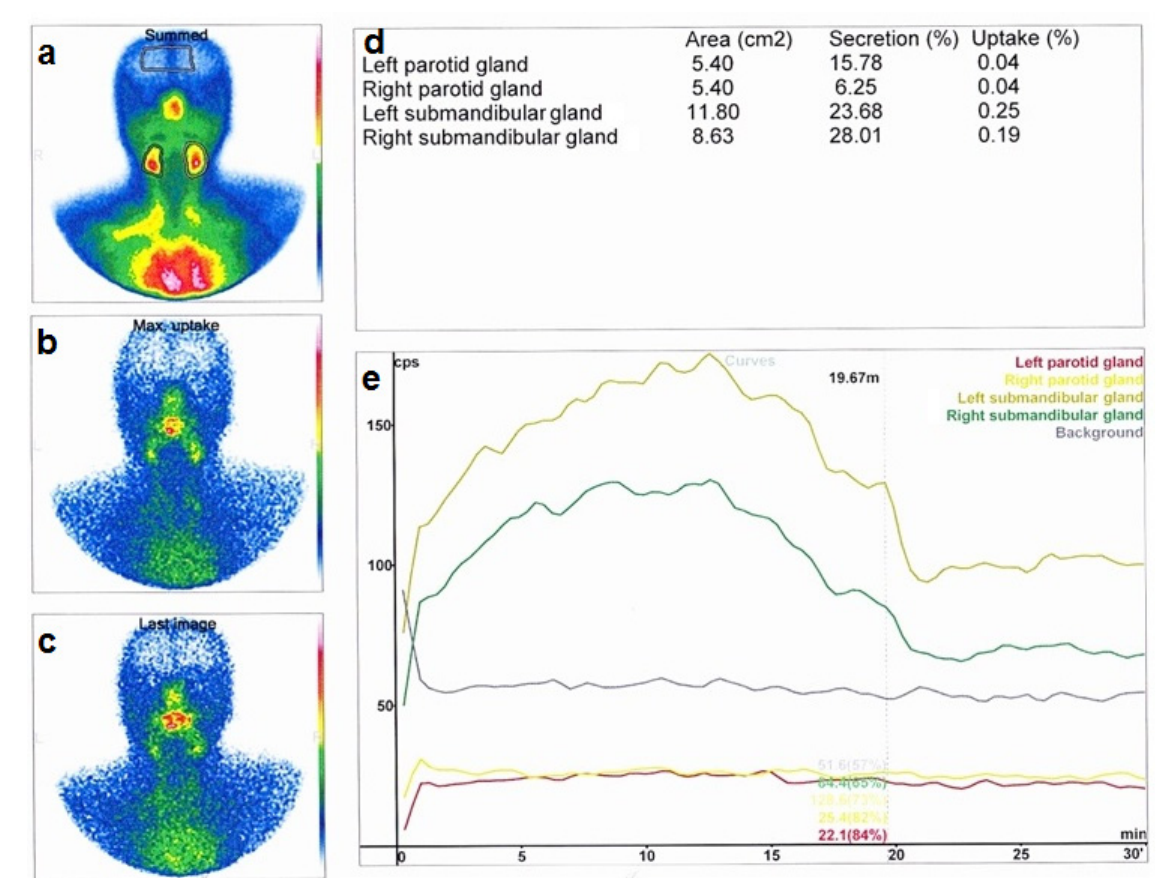
Fig. 1. Physiological uptake and excretion of 99m Tc-pertechnetate in submandibular salivary glands and parotid glands dysfunc- tion detected by dynamic salivary gland scintigraphy. Summed image (a) obtained from all frames depicts salivary glands (parotid glands are only faintly seen), submandibular glands ROIs and ROI for background correction placed over the brain. Picture (b) shows maximal radiotracer uptake in the salivary glands and (c) shows radiotracer activity in salivary glands 10 minutes after salivary glands gustatory stimulation. Values in (d) represent calculated uptake and excretion fractions and (e) shows time-activity curves for each salivary